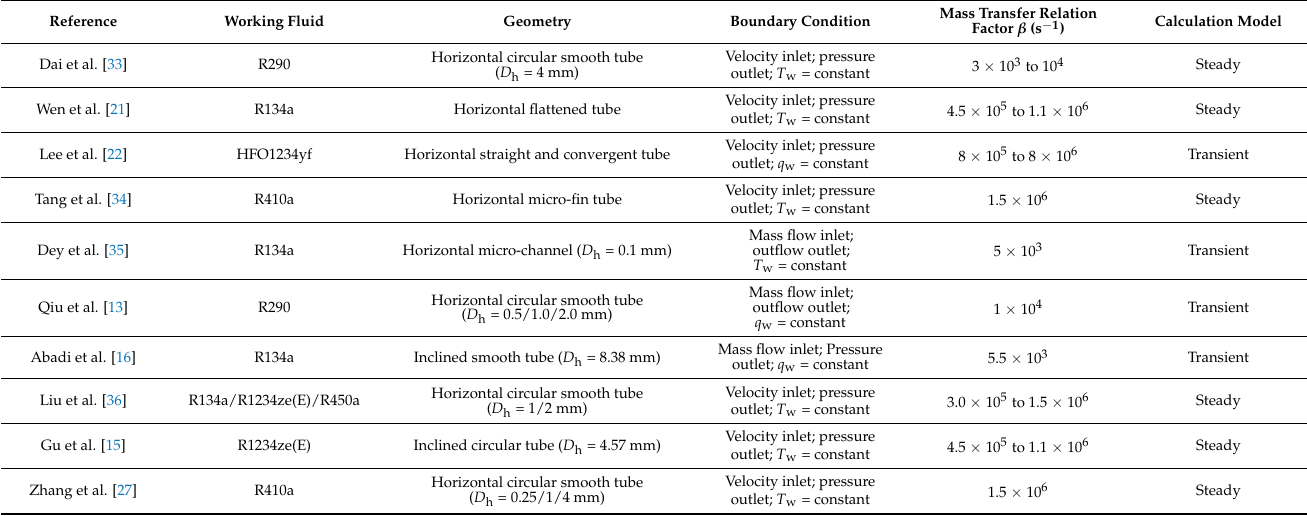
Table 2. Summary of literature about condensation coupled Lee model with VOF